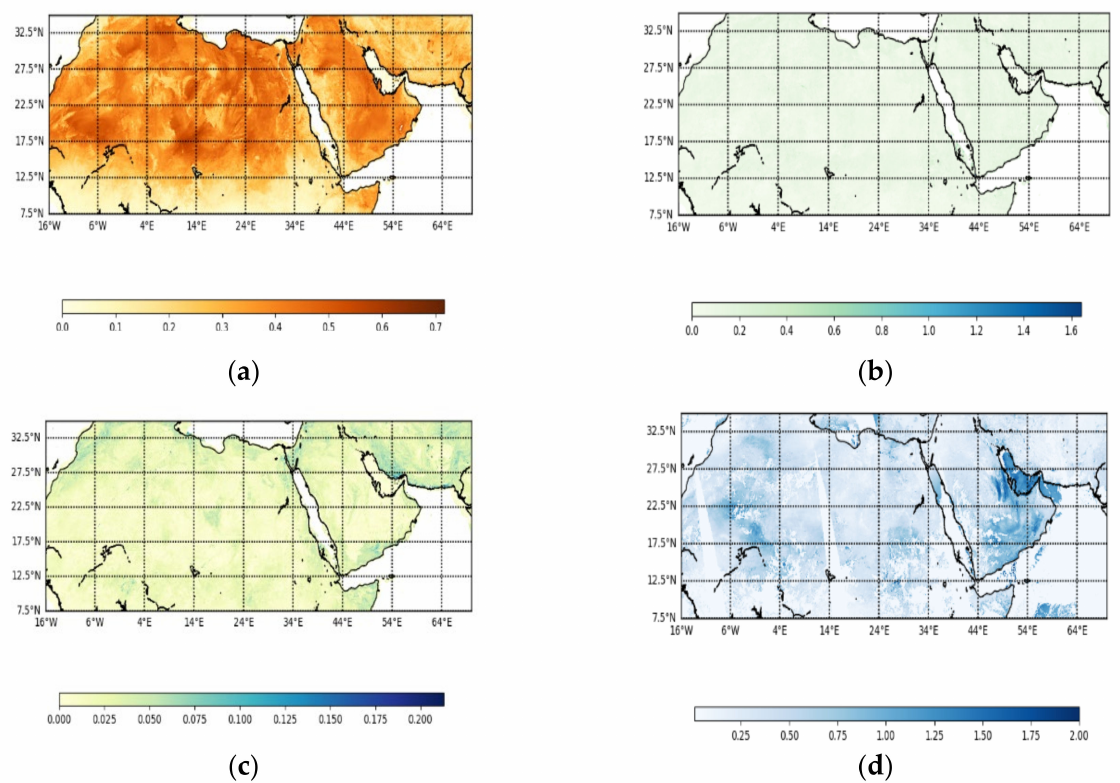
Figure 4. The weighting functions for the BRDF parameters and aot550 of the MODIS (Band 1) product. ( a ) Par1: The weight coefficient for a Lambertian kernel. ( b ) Par2: The weight coefficient for a Ross-Thick kernel. ( c ) Par3: The weight coefficient for a Li-Spare kernel. ( d )